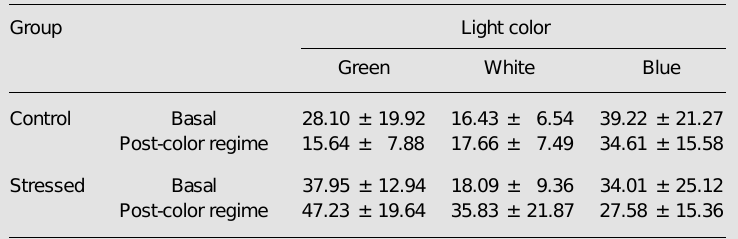
Figure 1. Effect of light colors on the stress response of adult Nile tilapia, Oreochromis niloti- cus . Data express the differ- ence in plasma cortisol levels between the basal and post- handling conditions (see Table 1). P values were obtained by the unpaired Student t -test for each color